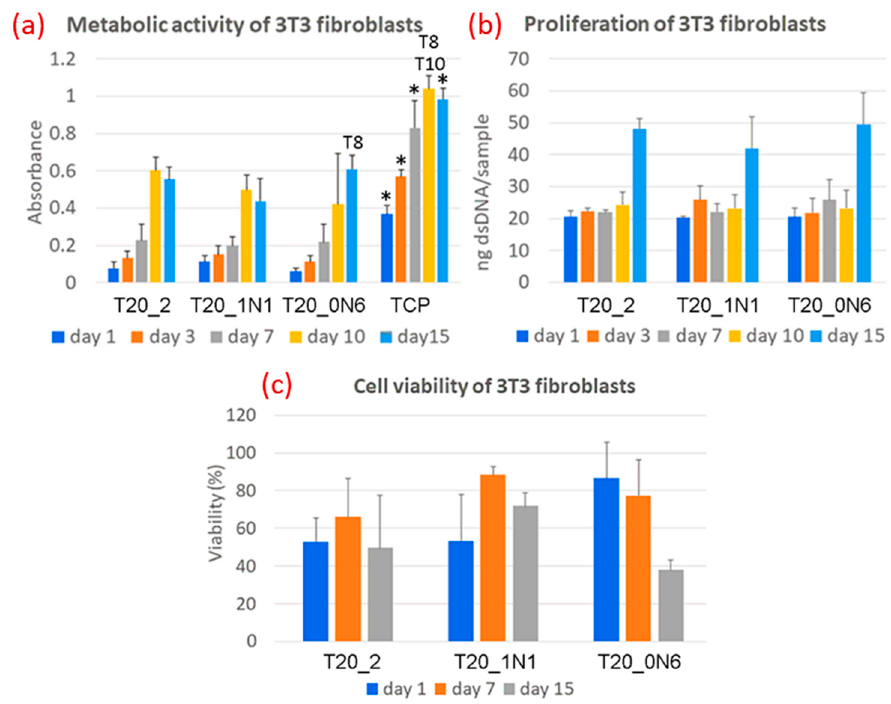
Figure 6. Biocompatible assays carried out on 3T3 fibroblasts immobilized on pristine PCL and TiN NPs-functionalized PCL scaffolds at various concentrations of NPs: ( a ) metabolic activity measured using the MTS assay; ( b ) proliferation using dsDNA assay; and ( c ) viability using live/dead assay. Tissue culture plastic (TCP) was chosen as a reference to provide the highest absorbance in MTS test. * refers to the statistical difference related to all other samples. No significant differences among scaffolds were observed in both cell proliferation and cell viability tests. In the statistics in a), T8 and T10 in the above columns display statistical differences between groups T20_1N1 or T20_0N6, respectively. All assays show results as a mean and standard deviation. Reproduced from Ref. [157].